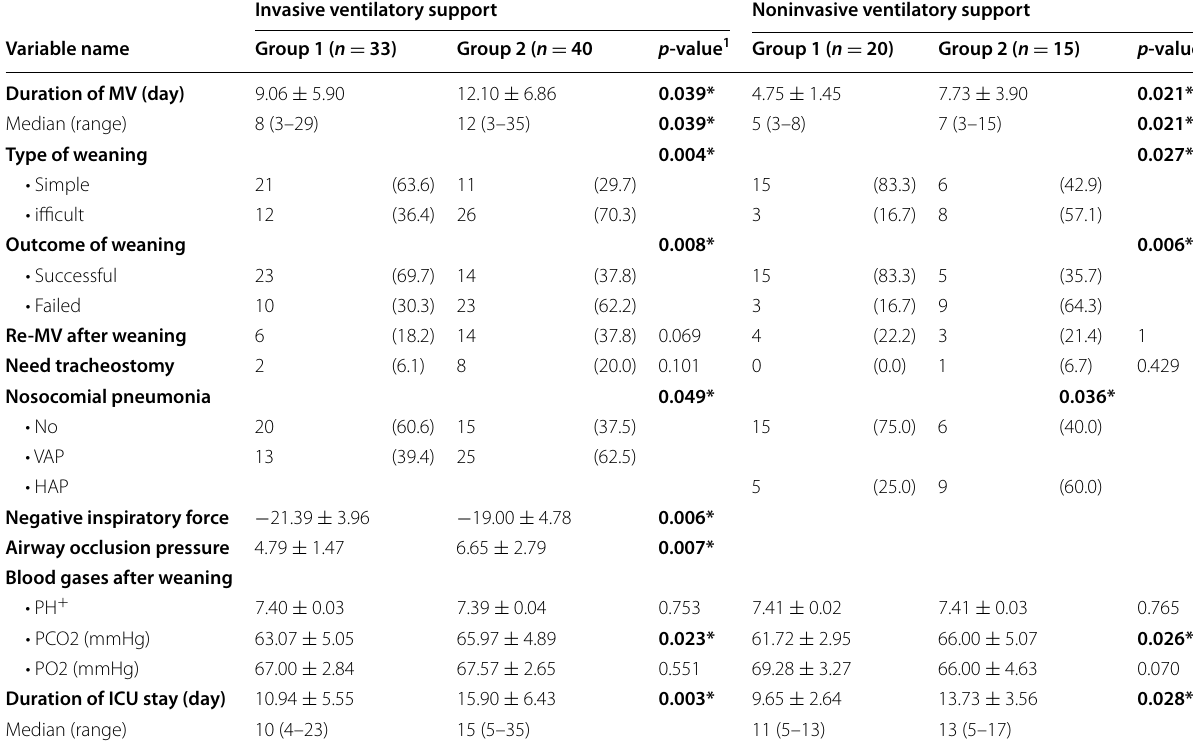
MV mechanical ventilation, VAP ventilator-associated pneumonia, HAP hospital-acquired pneumonia, PCO2 partial pressure of carbon dioxide, PO2 partial pressure of oxygen. Data are presented in the form of mean SD with median (range) or n (%). *Significance defined by P < ±